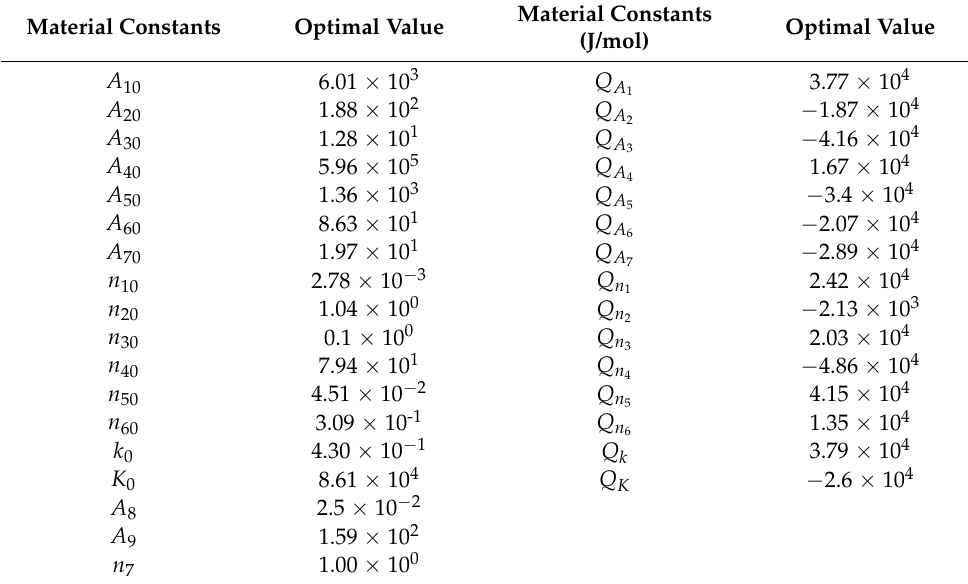
Table 3. Determined values of material constants in the loading stage.